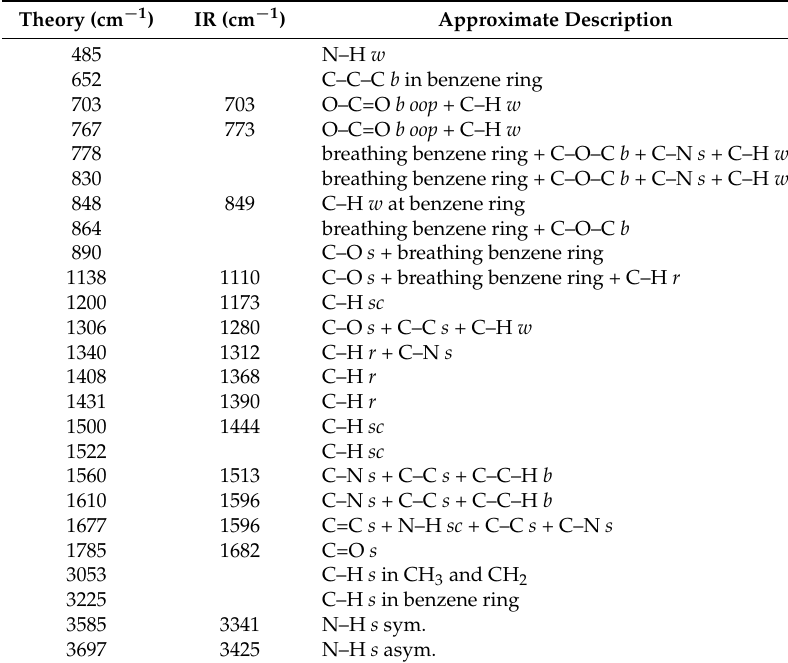
Table 1. Selected characteristic bands of benzocaine.